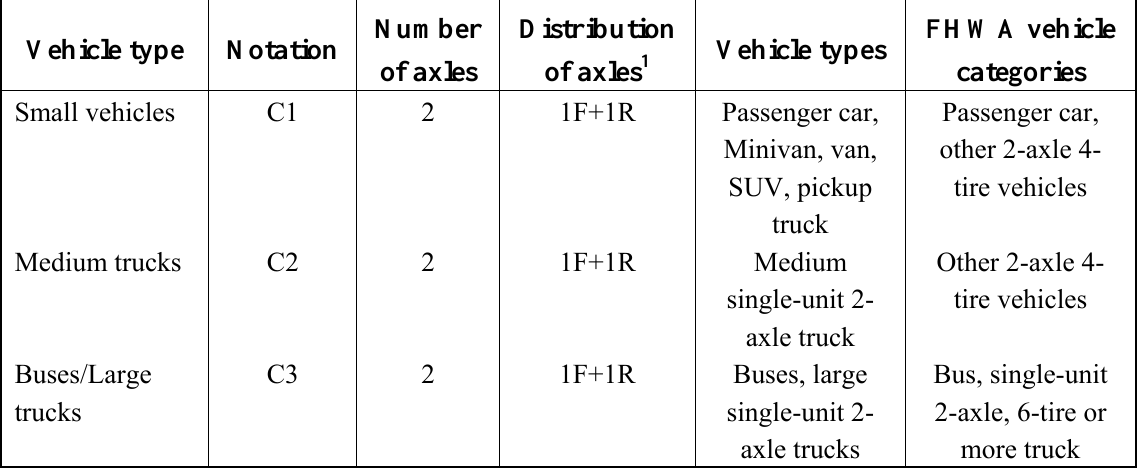
Table 1. Definition of Vehicle